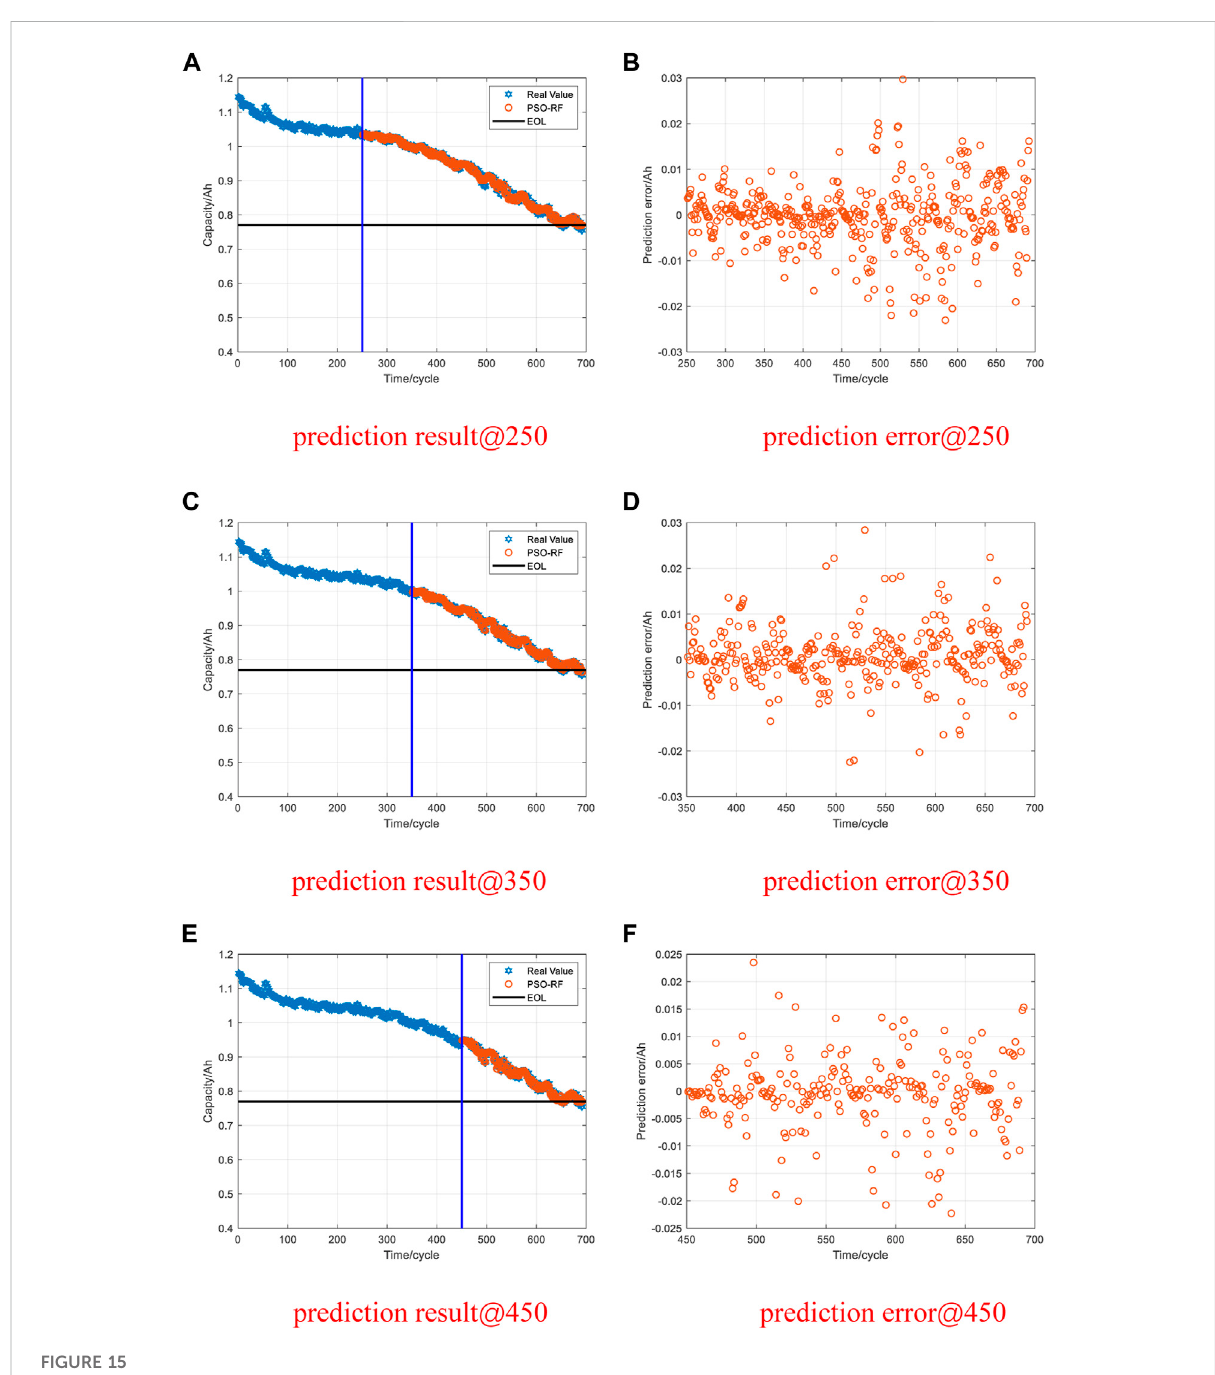
FIGURE 15 Results and errors of CS2-36